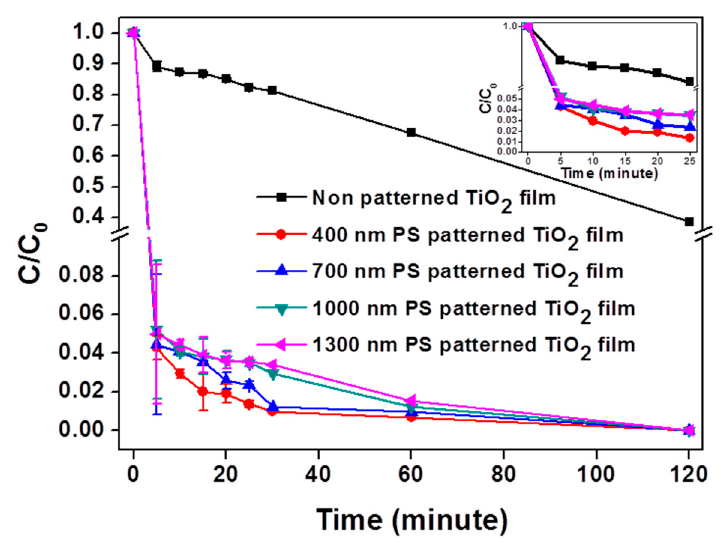
Figure 4. High resolution Ti 2p X-ray photoelectron (XP) spectra of the TiO 2 photocatalysts synthesized with 400 nm, 700 nm, 1000 nm, and 1300 nm patterned TiO 2 films.